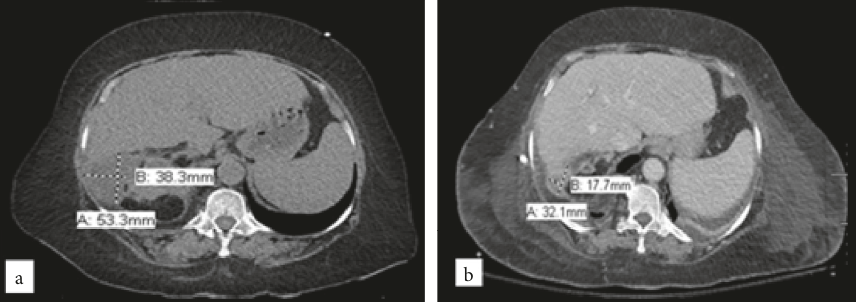
Figure 2: Computed tomography scan before starting antimicrobial therapy in Patient 2 demonstrates several central low-density fluid collections within the right perinephric space, below the liver margin, largest measuring approximately 5.3 × 3.8 cm (a). Computed to- mography at time of antimicrobial completion shows a residual fluid collection measuring 3.2 × 1.8 cm